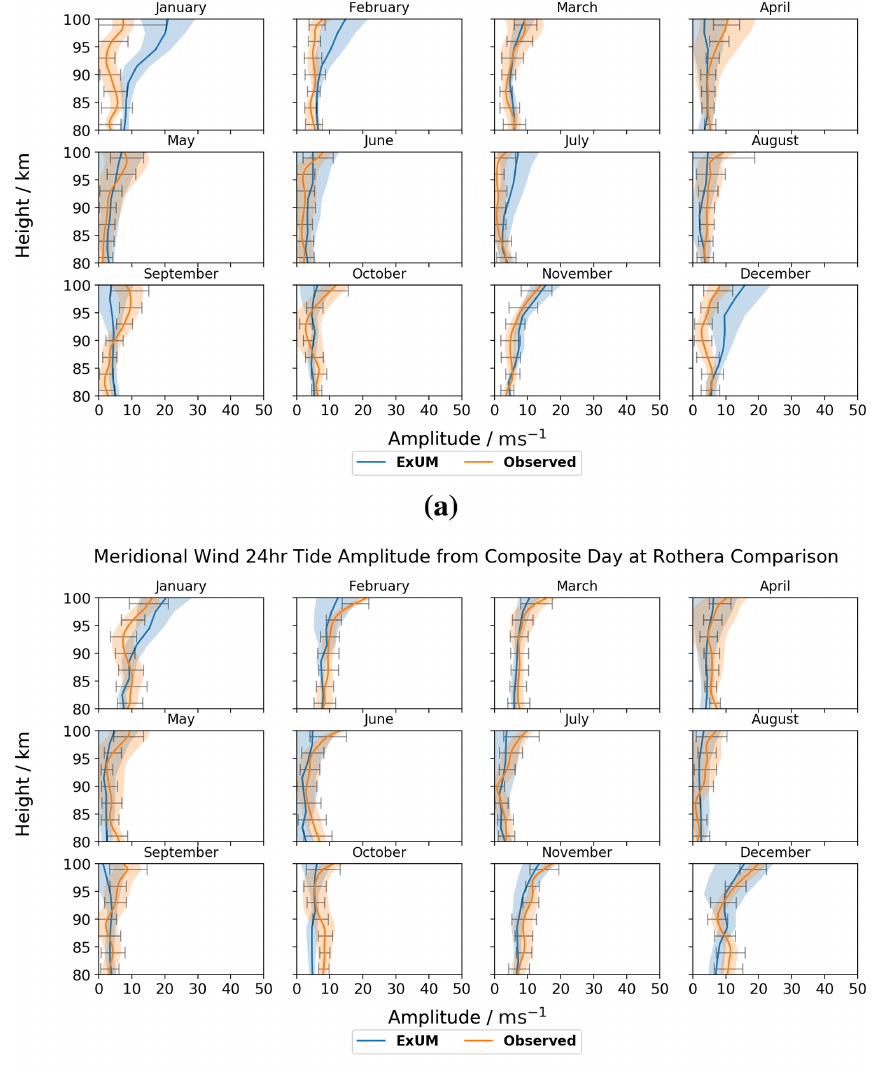
Figure 9. Amplitudes for each month as a function of height for the (a) zonal ( u ) and (b) meridional ( v ) components of the diurnal tide at Rothera. The shaded regions denote the standard deviation from the curve-fitting algorithm, and the black bars indicate the standard deviation from the mean of the measured amplitudes across the month. Both the amplitudes from the model (blue) and meteor radar (orange) are